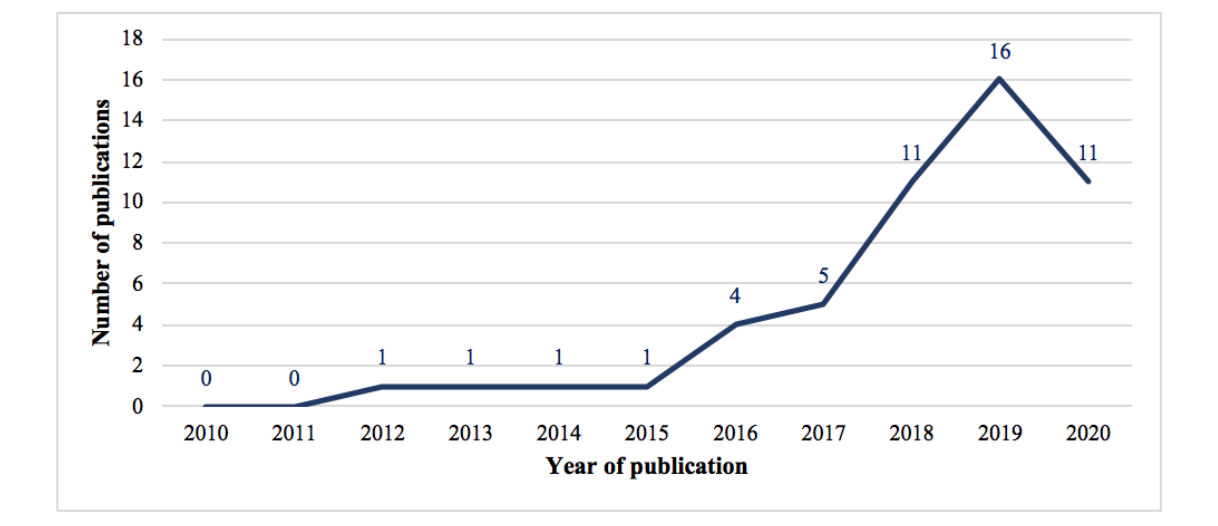
Figure 2. Distribution of the included articles from 2010 to